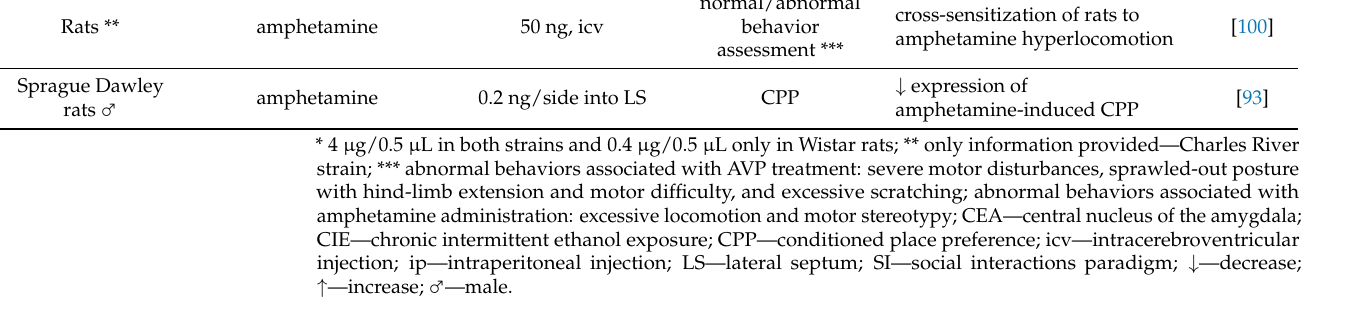
Table 4. The effects of AVPRs ligands on behavioral/rewarding effects of different drugs of